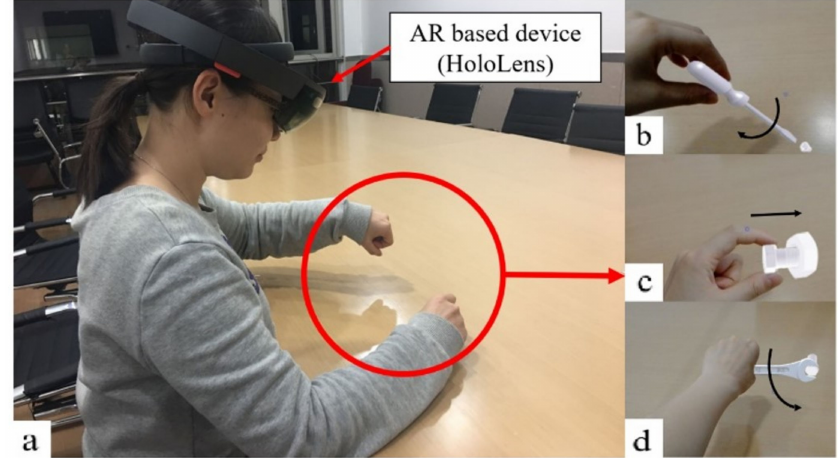
Figure 18. The experimental scenario of augmented reality assisted assembly training. ( a ) Experi- mental scenario, ( b ) screwing operation, ( c ) inserting operation, ( d ) fastening